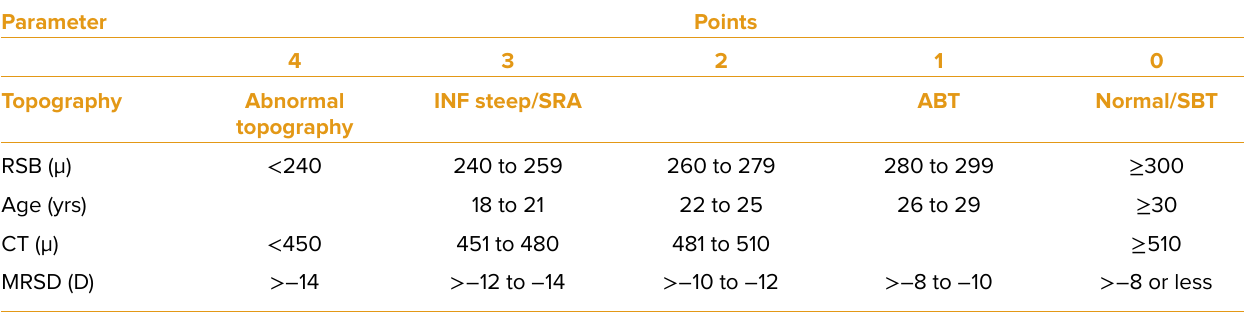
Table 1. Randleman ectasia risk score system for identifying eyes at high risk of developing ectasia after laser in situ keratomileusis Parameter Points 4 Topography Abnormal topography